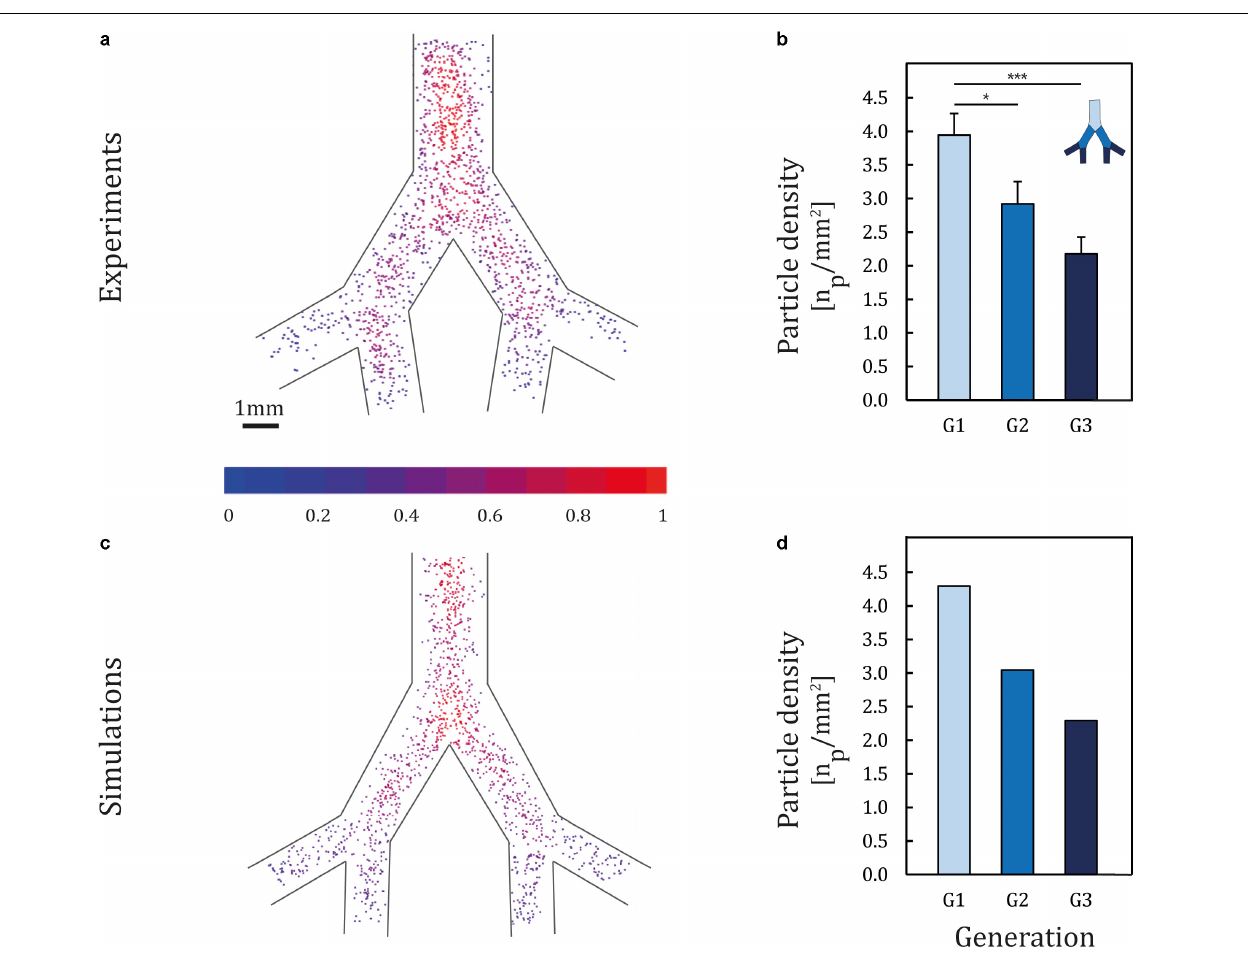
FIGURE 2 | Particle deposition patterns following exposure. Two micrometers of PS particles were aerosolized into the airway-on-chips in a horizontal position with respect to gravity at physiological airflow conditions corresponding to quiet breathing. (a) Ensemble deposition patterns imaged under fluorescence microscopy ( n = 8 models). The color-coded heat map quantifies particle concentration, defined as the number of neighboring particles within an 0.5 mm radius (results are normalized by the highest concentration in the tree). (b) Histogram of particle deposition density quantifying the average particle number in each generation normalized by airway area (mm 2 ). Error bars represent the standard error. Asterisks indicate significance corresponding to p < 0.05, 0.001 shown as * and ***, respectively. Corresponding (c) aerosol deposition patterns and (d) histograms of deposition density obtained from in silico CFD